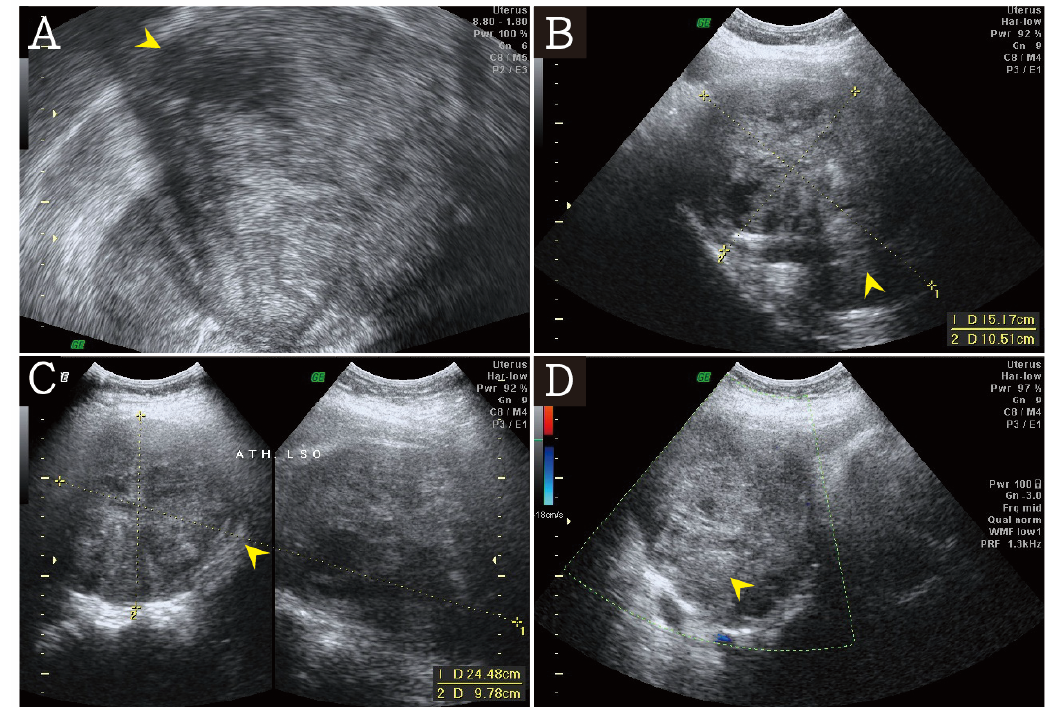
Figure 1. ( A ) The transvaginal ultrasound revealed a huge heterogeneous echogenicity mass (arrow head). ( B , C ) The heterogeneous mass was about 15.17 × 24.48 × 10.51 cm 3 (arrow head). ( D ) In doppler color flow mapping, no significant blood flow was noted in the heterogeneous mass (arrow head).